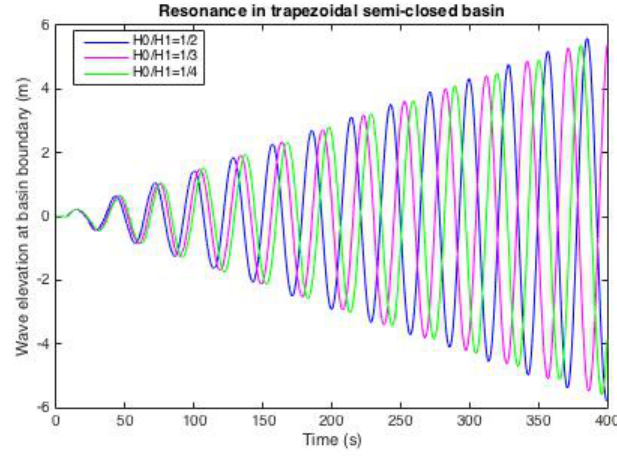
Figure 9. Simulation results for trapezoidal semi-closed